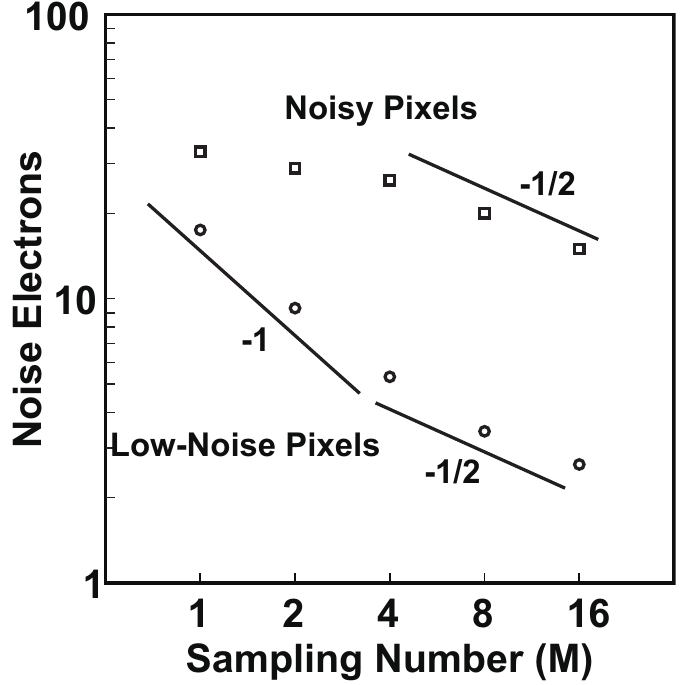
Figure 12. Temporal noise Charateristics for the sampling times of 1Mpixel CMOS